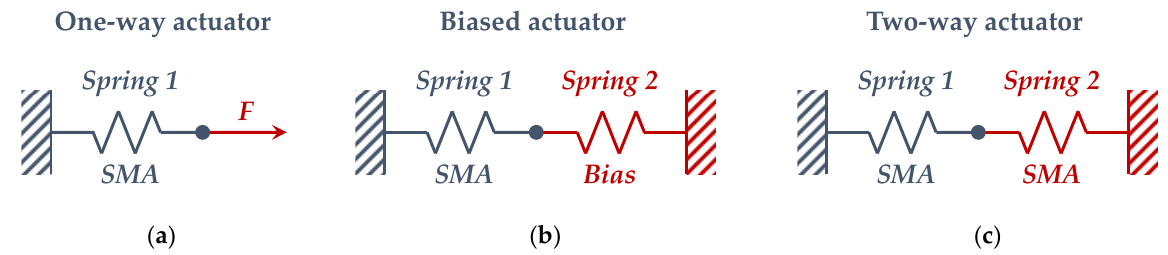
Figure 2. SMA-based actuator schemes with different antagonistic elements: ( a ) constant load; ( b ) antagonistic traditional spring; ( c ) antagonistic SMA spring.